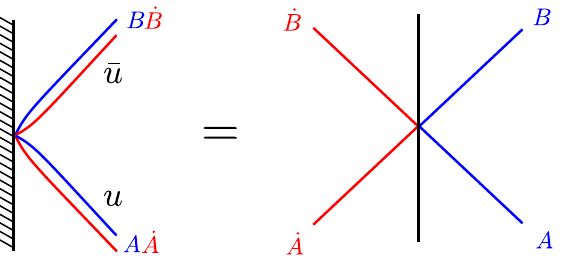
Figure 27 . The unfolding interpretation of the re(cid:13)ection matrix. One can regard the re(cid:13)ection process of a single magnon with PSU(2 j 2) 2 indices as the scattering process of two magnons, each with a single PSU(2 j 2)